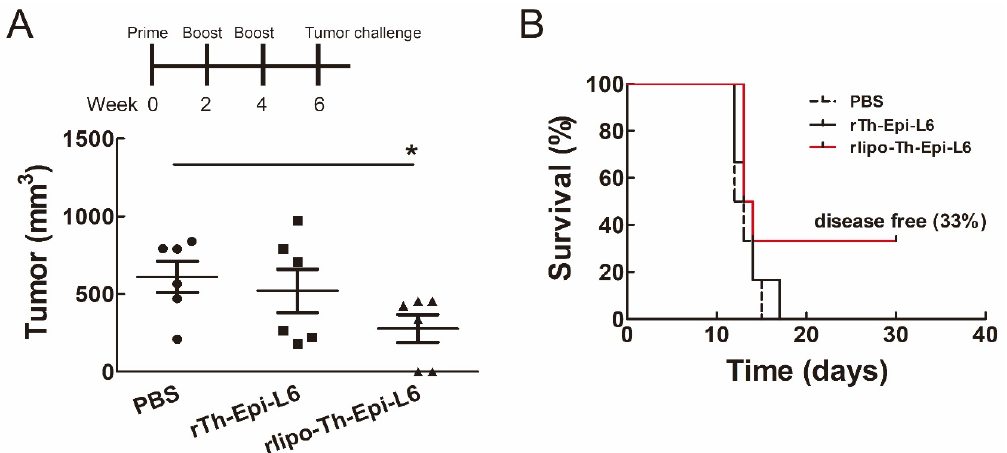
Figure 7. Immunization with rlipo-Th-Epi-L6 inhibited tumor growth and prolonged disease-free survival time. ( A ) C57BL/6 mice were immunized ( n = 6, per group) by injecting the indicated recombinant proteins 3 times at 2-week intervals, and then they were subcutaneously inoculated with EL4 / L6 thymoma cells (1 × 10 5 / mouse). The tumor volumes were measured 3 times per week. The graphs show the mean ± SEM on day 12 after tumor challenge. * p < 0.05 by t -test. ( B ) The disease-free survival rates were